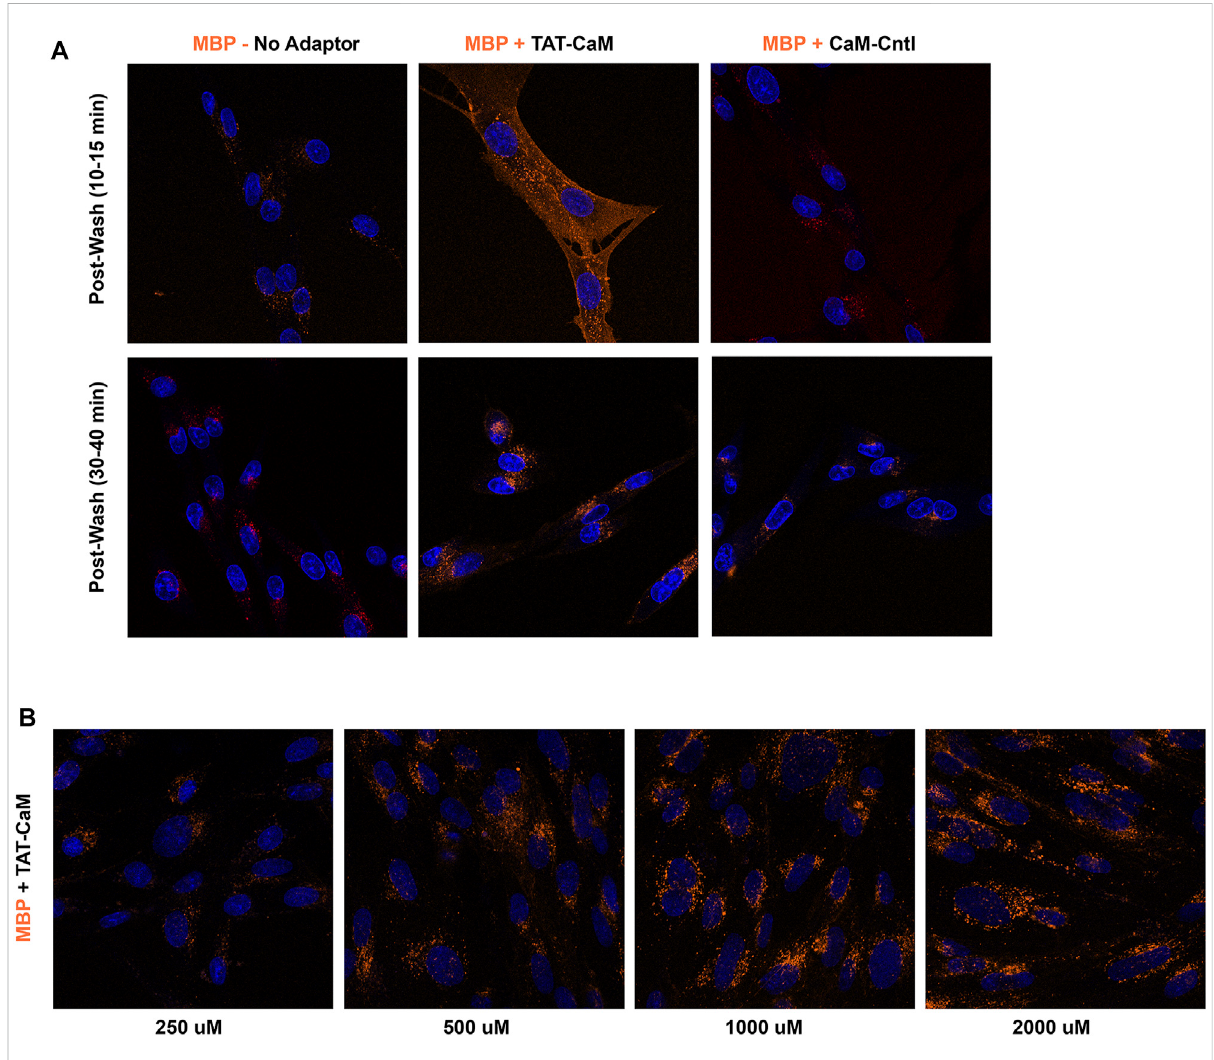
FIGURE 5 TAT-CaM speci fi cally induces MBP-CBS internalization but requires µm concentrations. (A) InternalizationofMBP-CBS alone (left panels), with equimolarwith TAT-CaM (center panels) orwith “ TAT-less ” CaMcontrol(rightpanels)following1 hincubation with BHKcells ingrowth media. Cells were washed (PBS x2) and imaged immediately (top panels) or later (bottom panels) in imaging media with NucBlue. (B) Internalization of equimolar MBP-CBS and TAT-CaM at 4 concentrations following a 2 h incubation, washing (PBS x2) and imaging in media with